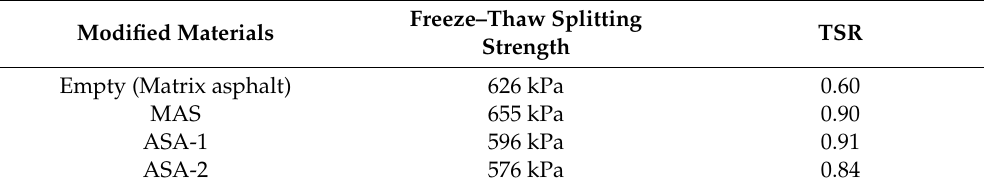
Figure 6. ( a ) Freeze–thaw splitting strength and ( b ) TSR of asphalt mixture, where Empty represents asphalt mixtures employed with matrix asphalts, and MAS, ASA-1 and ASA-2 are the asphalt mixtures prepared using the asphalts modified with MAS, ASA-1 and ASA-2, respectively. Table 13. Freeze–thaw splitting strength and strength ratio of asphalt mixtures.